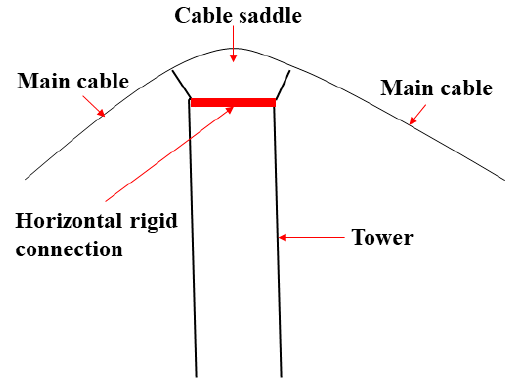
Figure 3. Schematic diagram of the connection between cable saddle and tower.